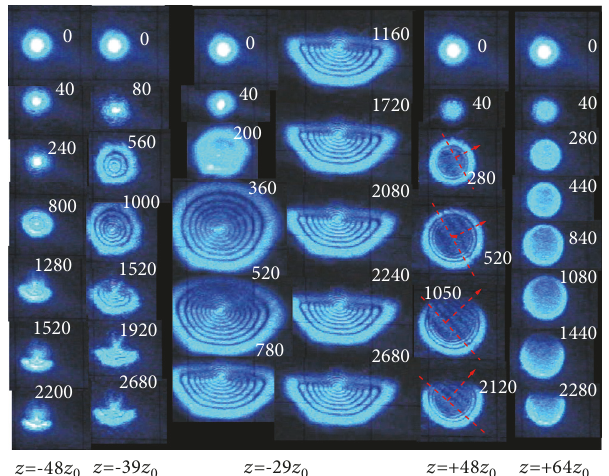
Figure 3: The establishment of the beam trace profile for different positions of the nonlinear medium. The numbers have a time (ms) after the start of the lighting.